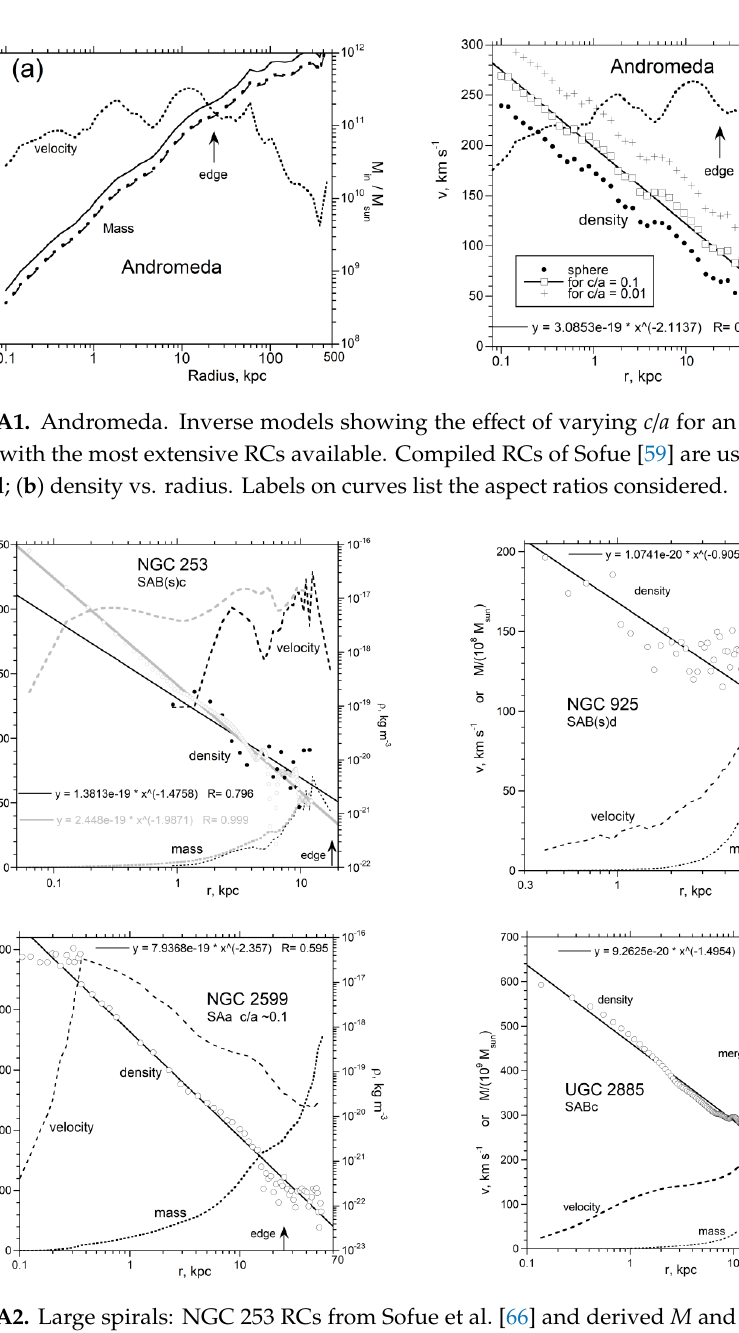
Figure A3. Comparison of moderate-sized galaxies: NGC 3034 is the irregular M82 galaxy. RCs from Greco et al. [63]. An abrupt drop off in density is not observed, because RC data are limited to the visible galaxy. NGC 7793 RCs from deBlok et al. [54] have fairly low velocity, and lower density.